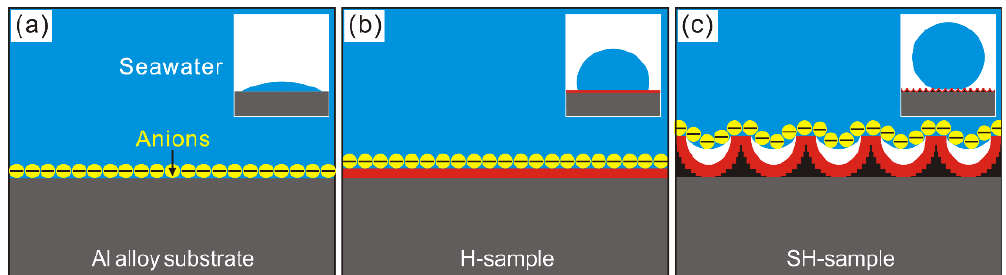
Figure 7. Interfacial relationships of ( a ) Al alloy substrate, ( b ) modified substrate (H-sample) and ( c ) modified deposited sample (SH-sample).